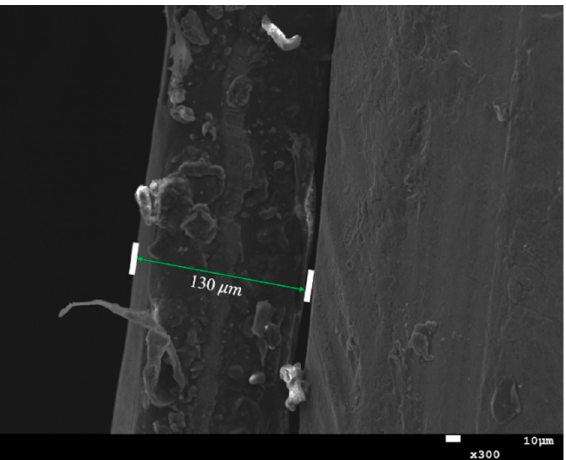
Figure 7. Cross-sectional view of the thin film on the surface of the Cu-TiO 2 optical electrode.